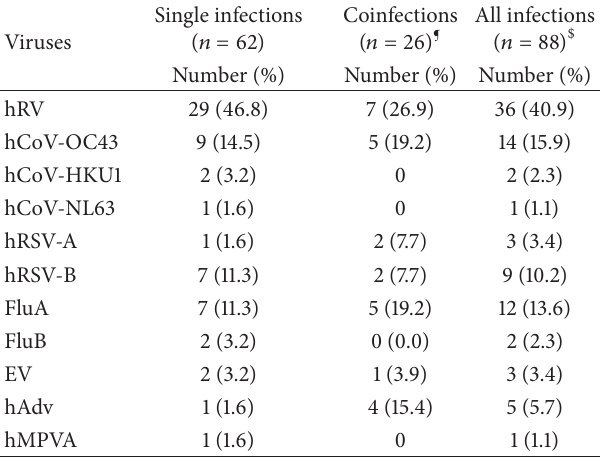
Table 2: Viruses identified in patients with upper respiratory tract